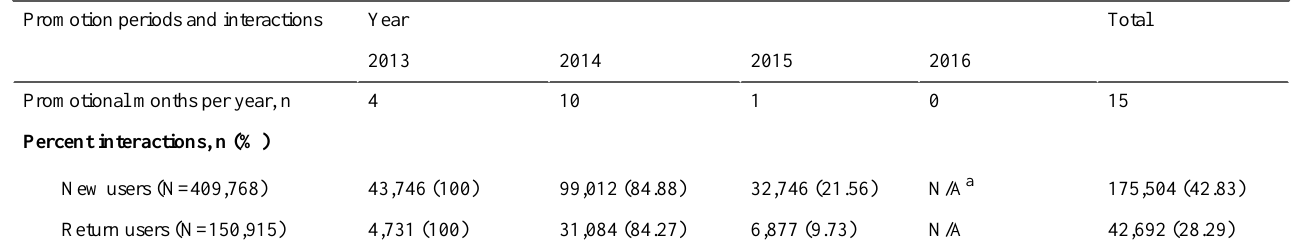
Table 8. Promotion periods per year and interactions among new and return users. TotalYearPromotion periods and interactions